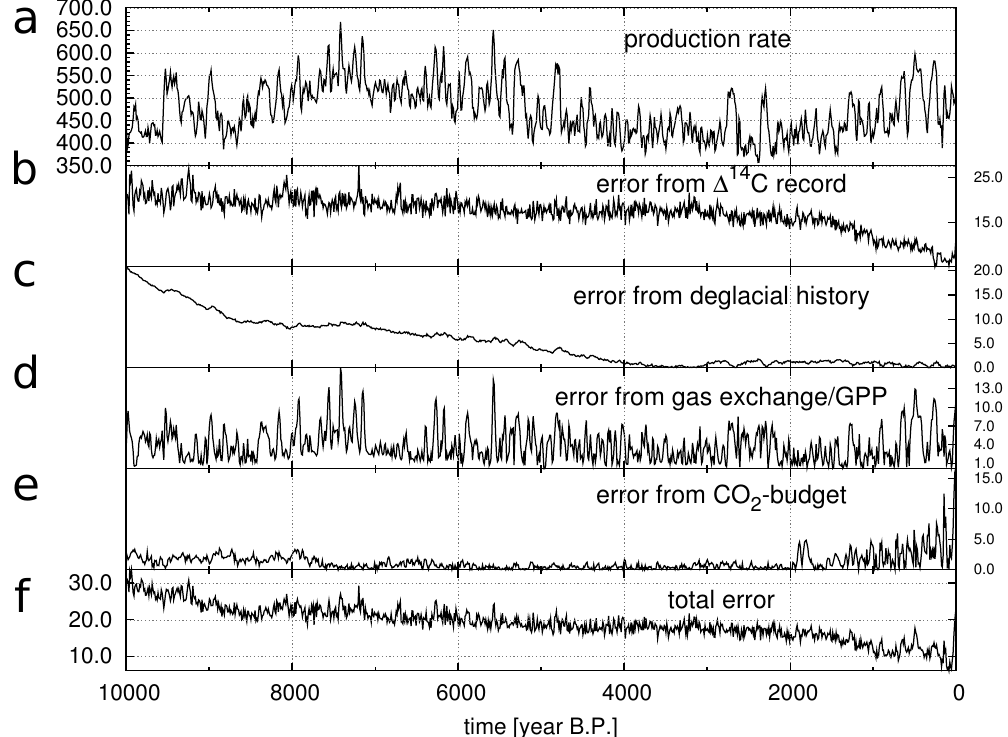
Fig. A1. Assessment of uncertainties in our production rate record in molyr − 1 . (a) Radiocarbon production rate (arithmetic mean of CIRC and BIO); (b) the uncertainty stemming from the pre-Holocene carbon cycle evolution calculated as the absolute difference between results from simulations BIO and CIRC; (c) the smoothed 1 σ error from the 1 14 C record (as shown in Fig. 2b) is calculated by a Monte Carlo approach including 100 individual simulations; and (d) the uncertainty in air–sea and air–land fluxes deduced by sensitivity experiments. The total error in production (e) varies between 30 and 5molyr − 1 , corresponding to a relative error of ∼ 6 to 1.5%. The bulk uncertainty in the average level of Q resulting form an uncertain ocean (and land) inventory is not included in this calculation. We estimate this uncertainty to be ∼